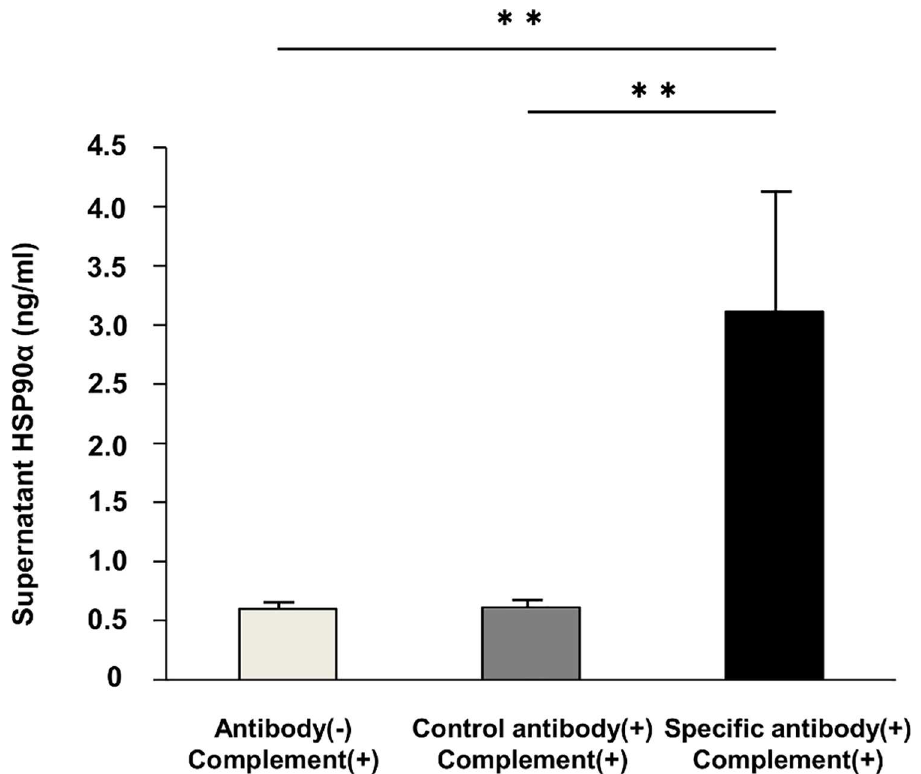
Fig 5. The HSP90 α concentrationin the supernatant of humanaorticendothelialcellsunder complement attack. Levels of HSP90 α in the supernatants of humanaorticendothelial cells (HAEC)in three groups were measuredby ELISA. Bars show mean ± SD fromthreeindependent experiments. Statistically significant differences were observedbetween the subgroupsof HAEC that were coculturedwith anti-HLA IgG and coculturedwith nonspecificIgG. ** p <